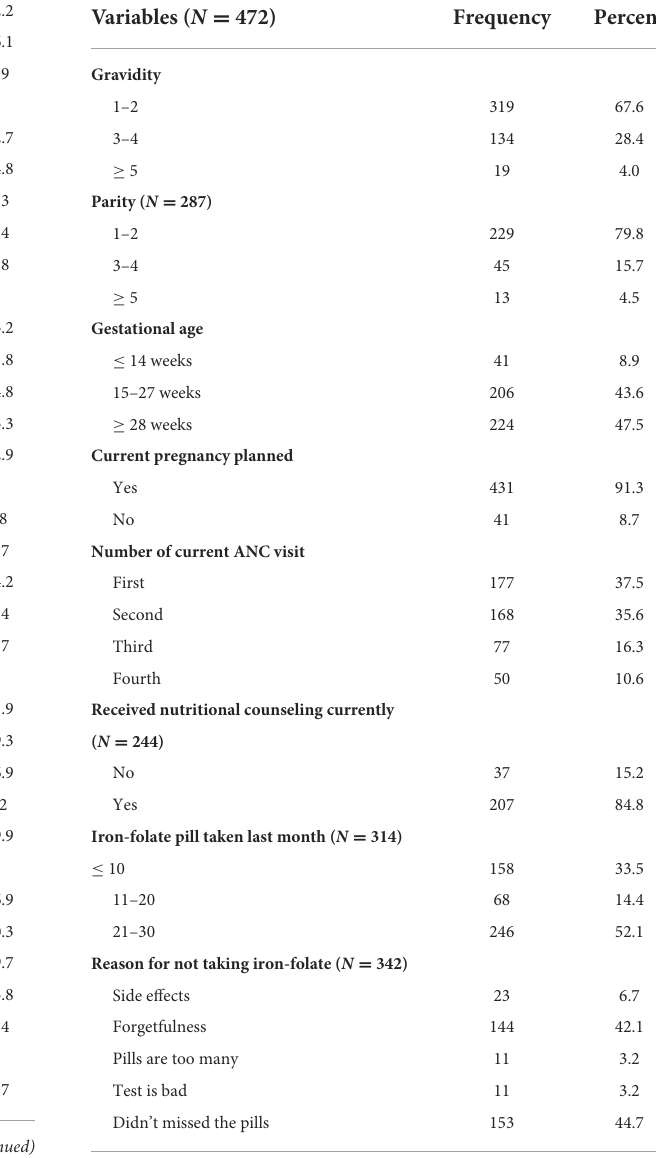
TABLE 2 Obstetrics and other related characteristics of pregnant mothers attending ANC service in East Shoa zone, Ethiopia, from June to August